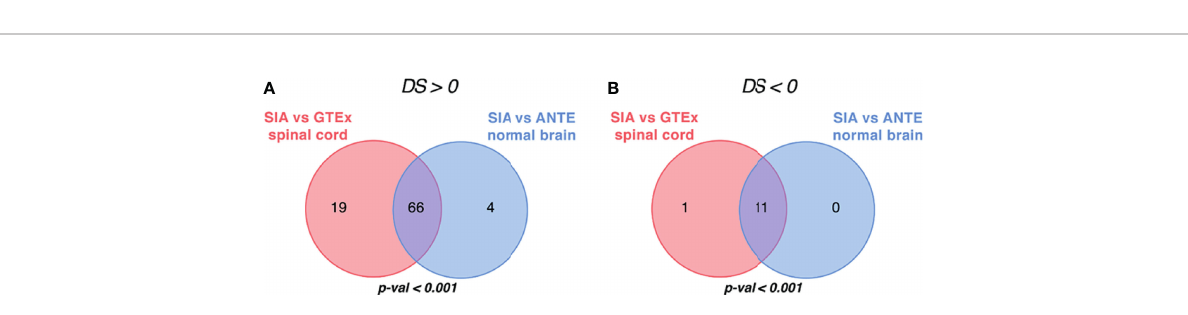
FIGURE 7 | Top 20 targeted therapeutics ranked by drug score for spinal intramedullary astrocytomas (SIAs) separately normalized on (A) healthy GTEx spinal cord and (B) ANTE normal brain samples. Targeted therapeutics that are common between the two top-20 lists are shown with green